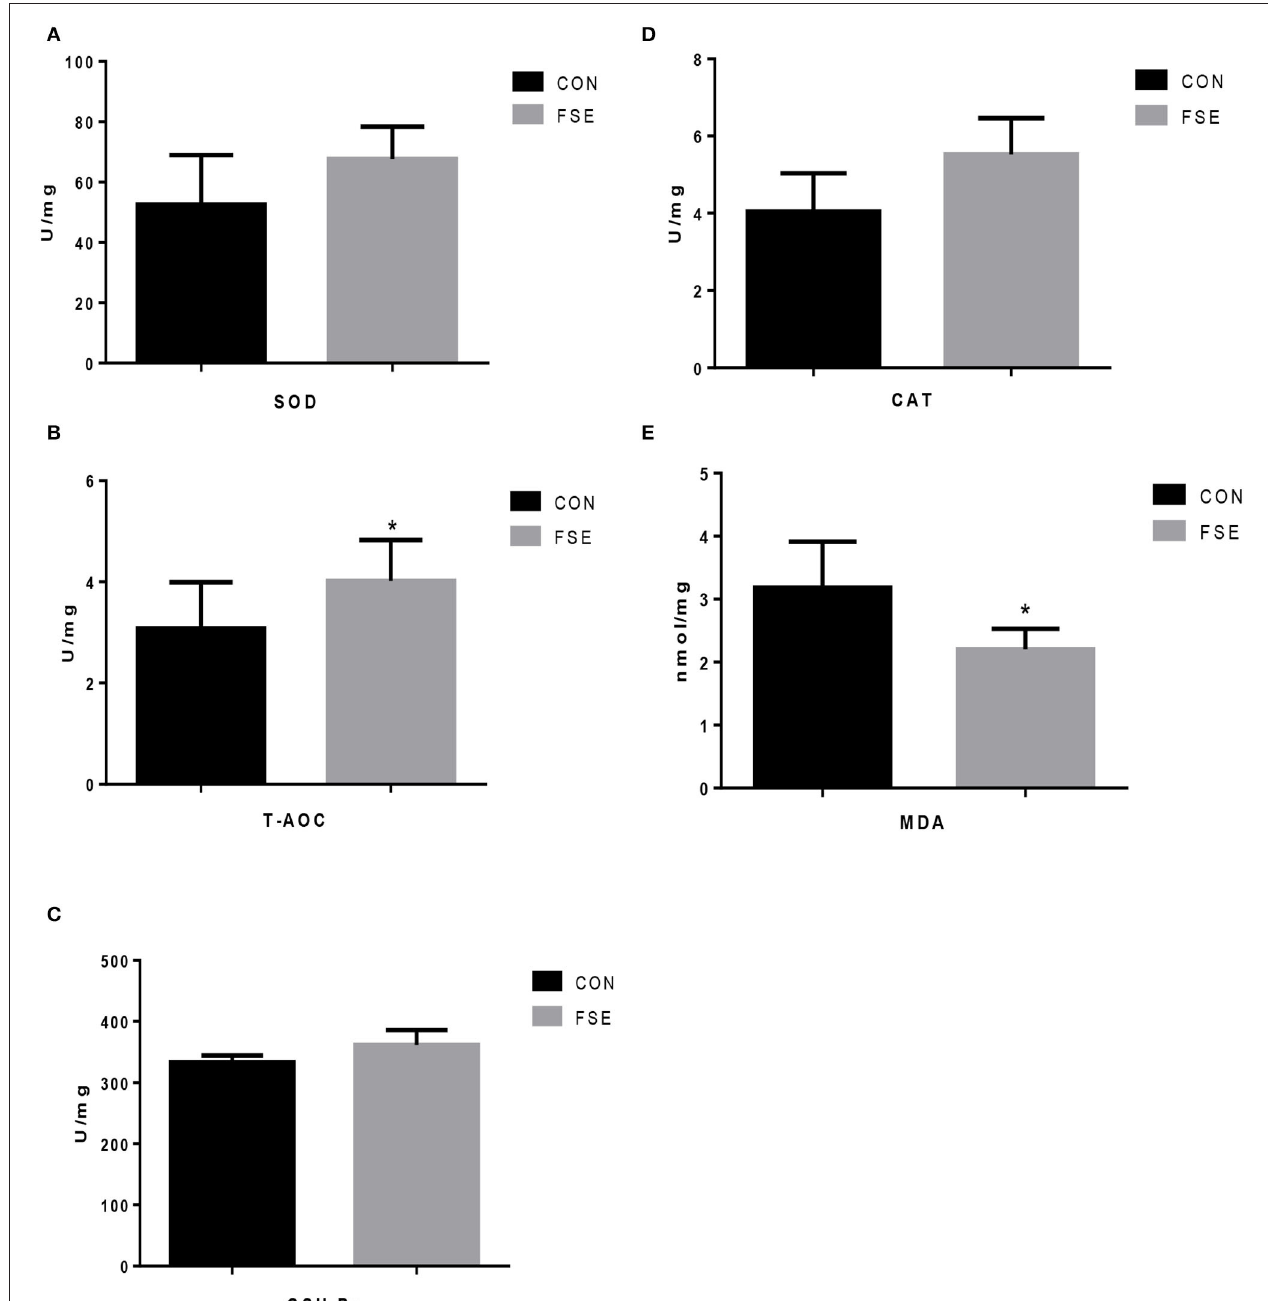
FIGURE 2 | Effects of Forsythia suspensa extract on antioxidant status of placenta in lactating sows. CON, control treatment; FSE, Forsythia suspensa extract treatment; (A) SOD, superoxide dismutase; (B) T-AOC, total antioxidant capacity; (C) GSH-Px, glutathione peroxidase; (D) CAT, catalase; (E) MDA, malondialdehyde. All values are expressed as means ± SEM ( n = 6). * P <